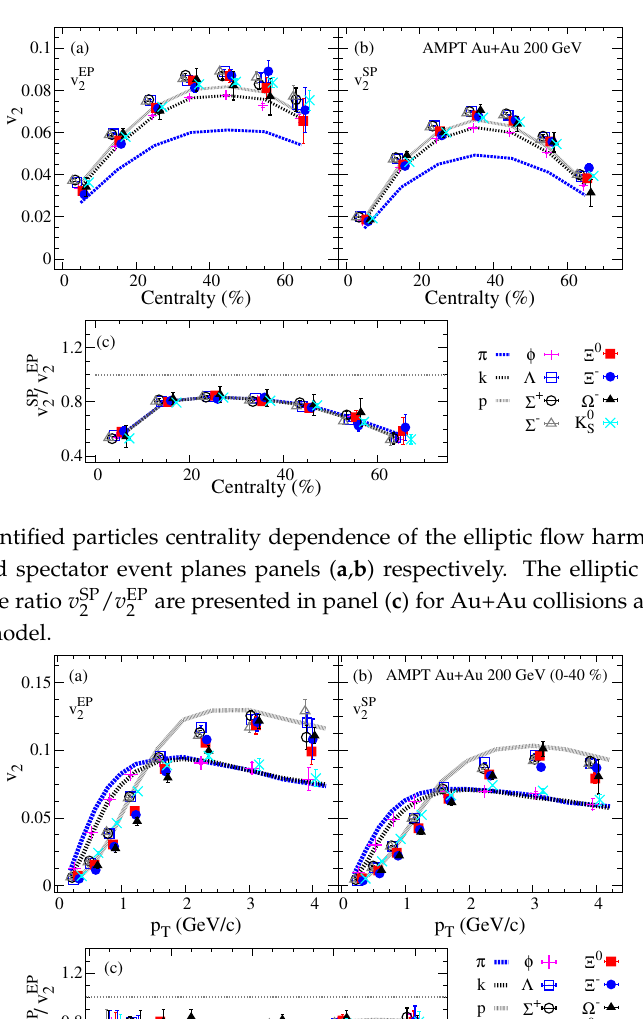
Figure 4. The identified particles p T dependence of the elliptic flow harmonic with respect to participant and spectator event planes panels ( a , b ) respectively. The elliptic flow fluctuations represented by the ratio v SP are presented in panel ( c ) for Au+Au collisions at / v EP 2 2